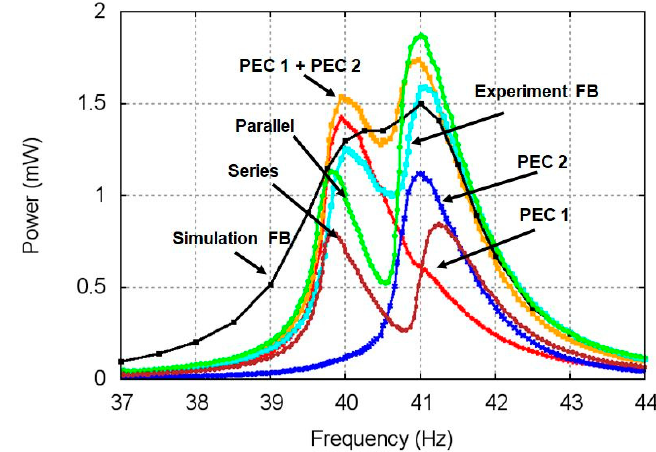
Figure 10. Power of parallel and series connection compared with the optimum power (designated as “PEC 1 + PEC 2”). FB: full bridge. “PEC 1 + PEC 2”). FB: full bridge.